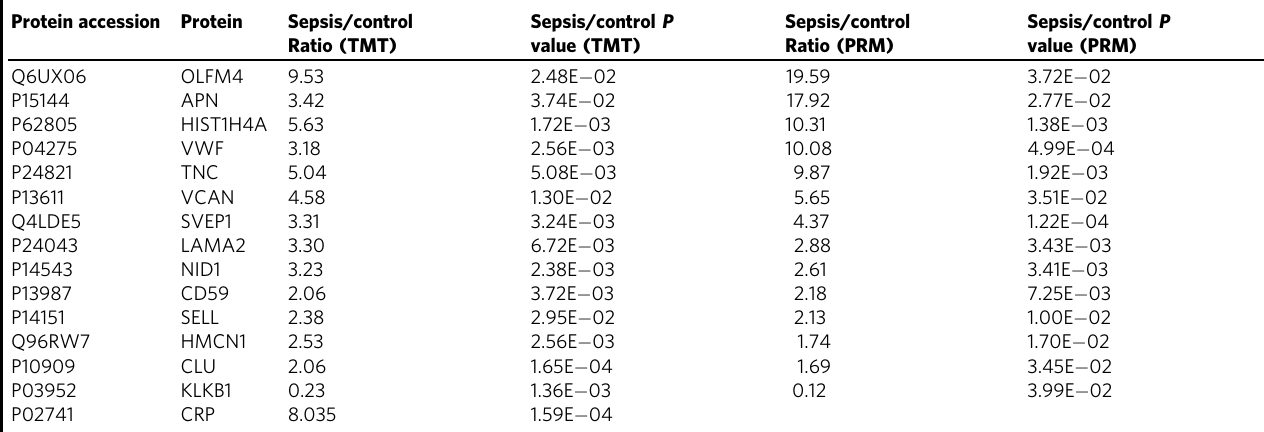
Table 1 The differentially expressed proteins between the LC-MS/MS and PRM patient cohorts. Protein accession